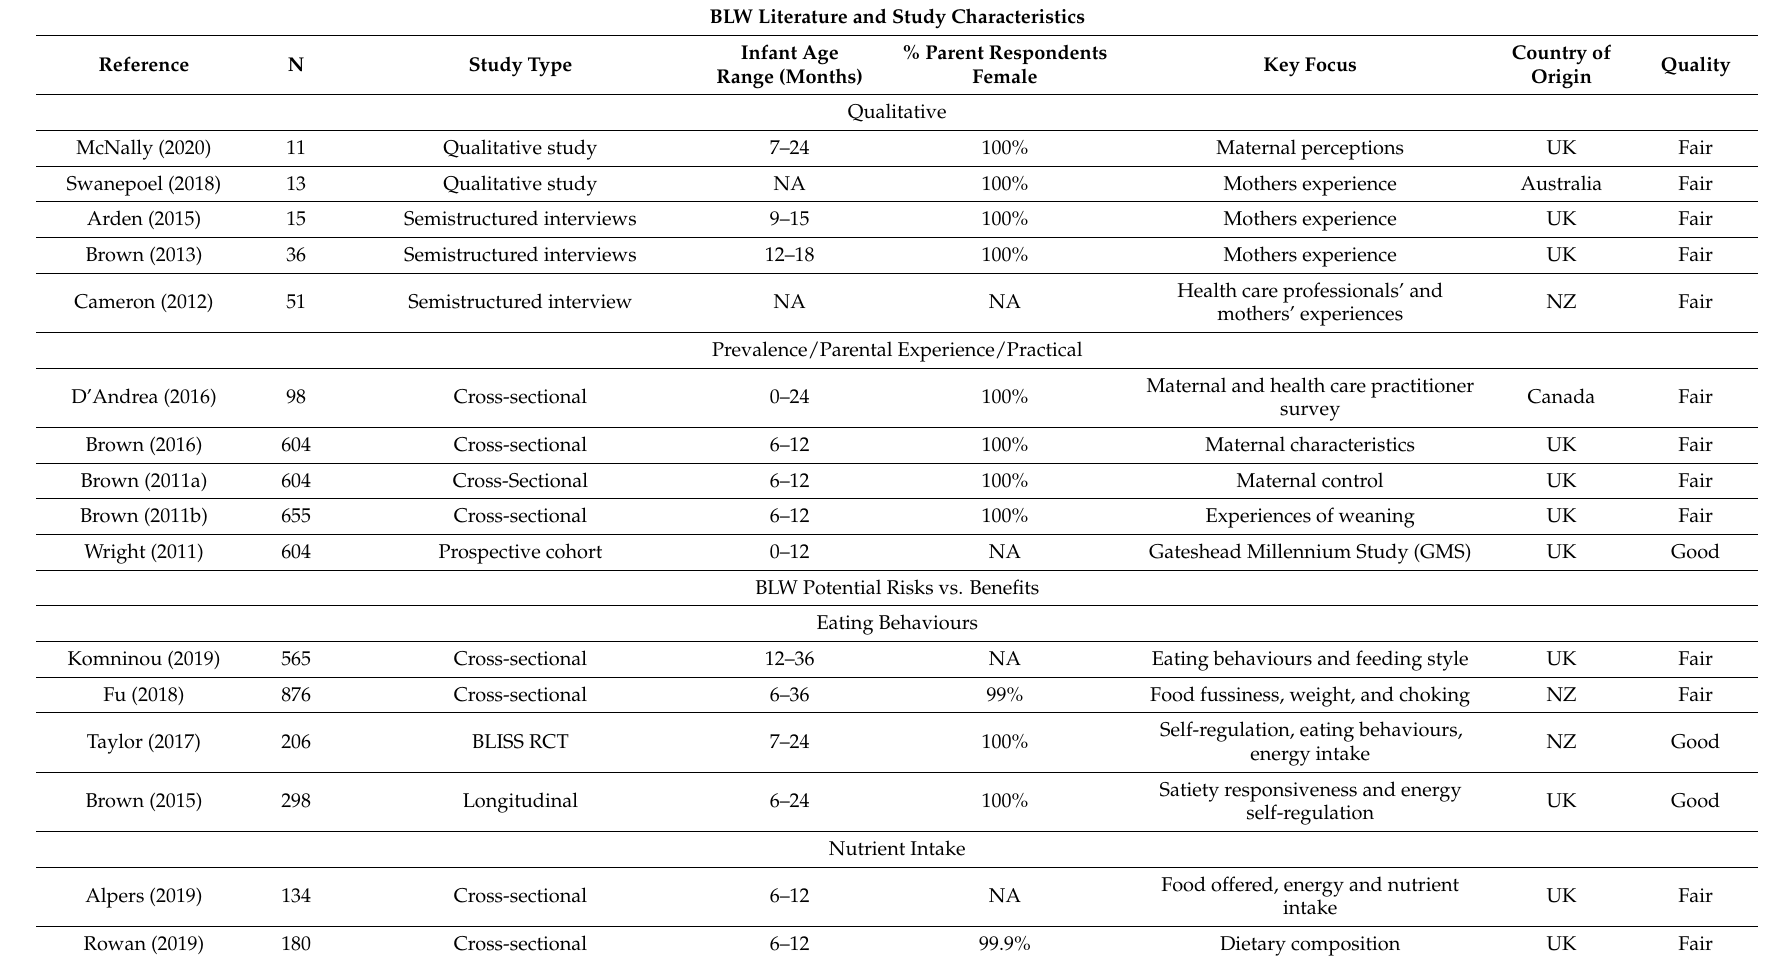
Table 1. BLW study